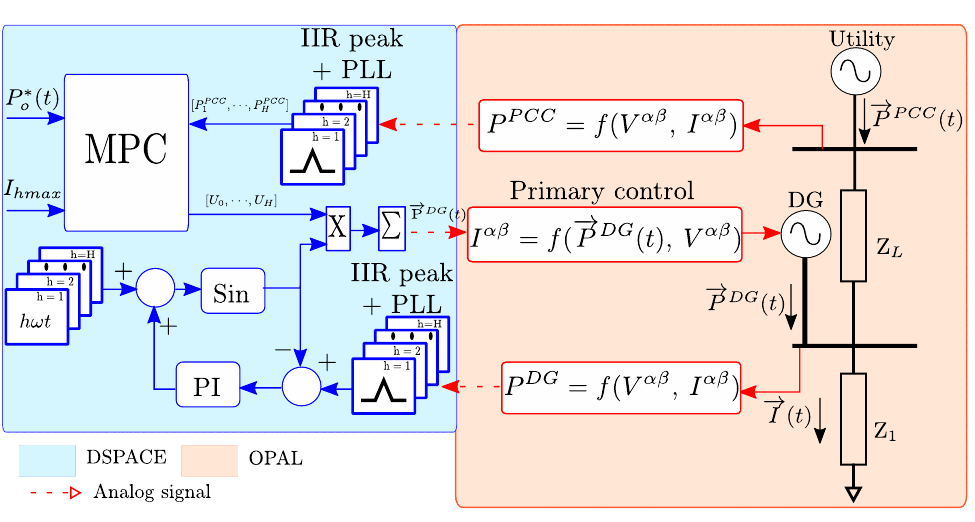
Figure 2. Proposed control